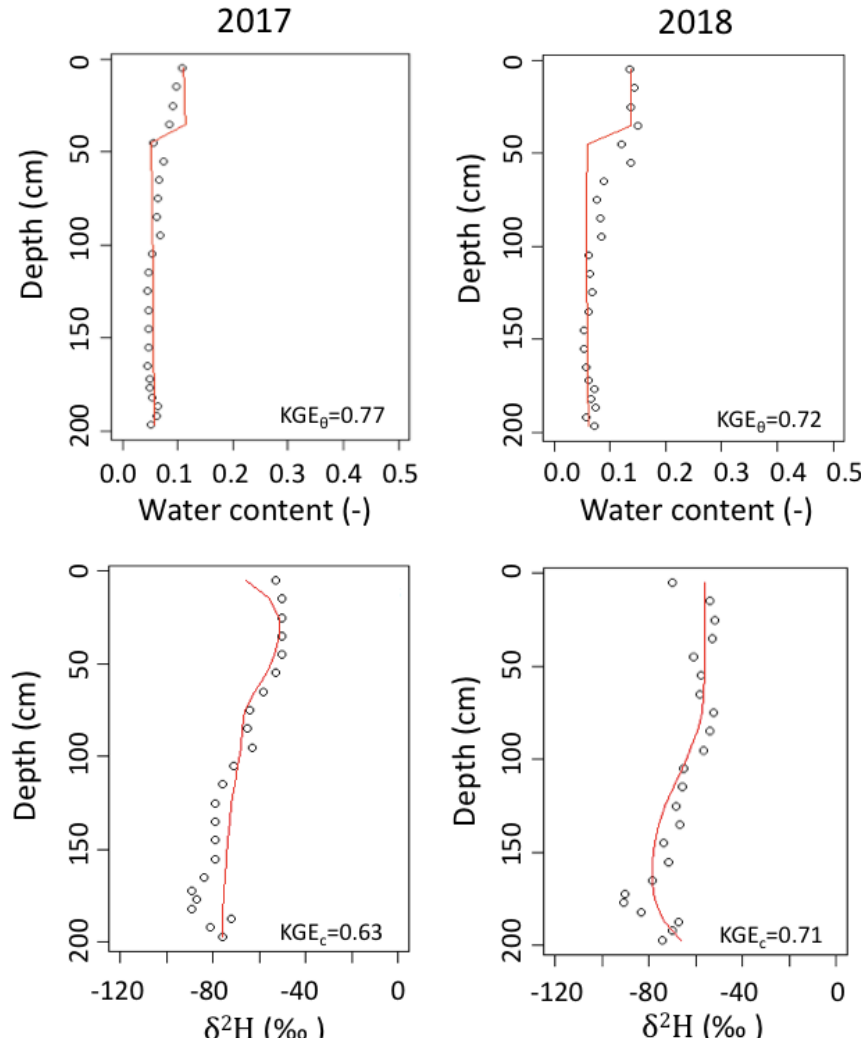
Figure 5. Observed ( circles ) and simulated ( lines ) water content ( top ) and δ 2 H ( bottom ) soil profiles at site SLB with the best parameter set.